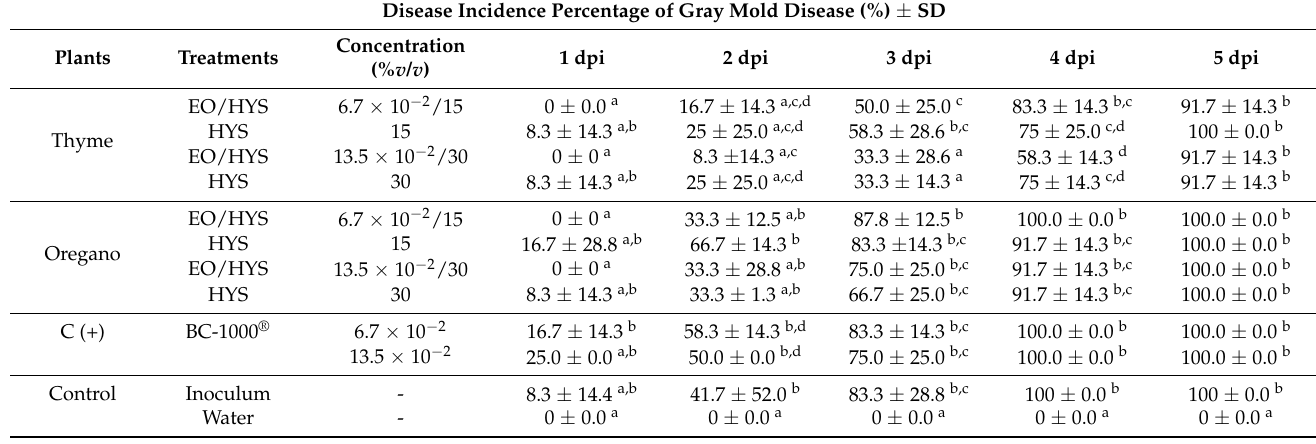
Table 5. Effect of different treatments applied in vivo on tomato fruits on the incidence of Botrytis cinerea disease over five days post-inoculation (dpi).